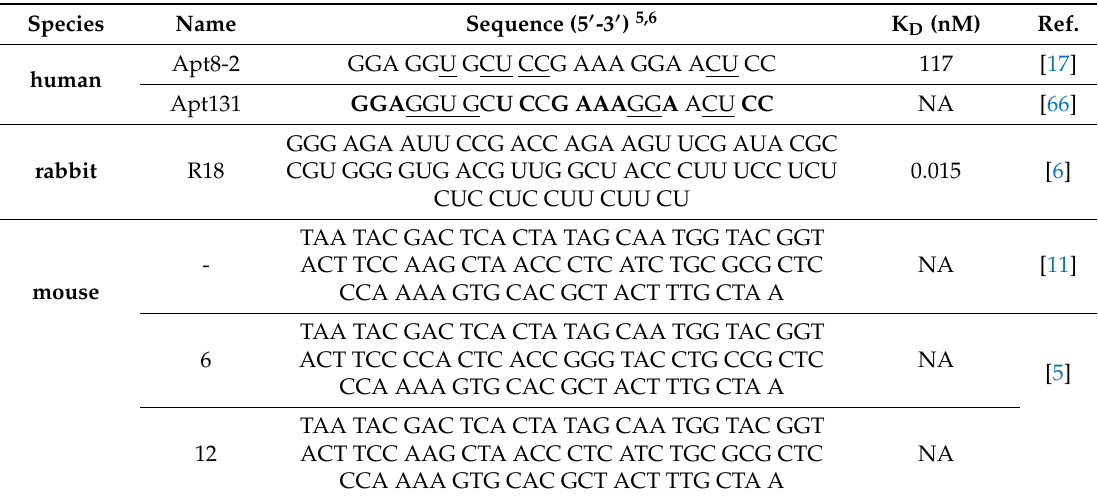
Table 4. IgG Fc domain specific aptamers with their sequences and K D